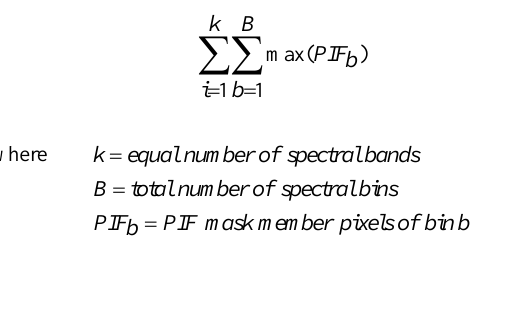
Table 2. Acquisition dates of the processed